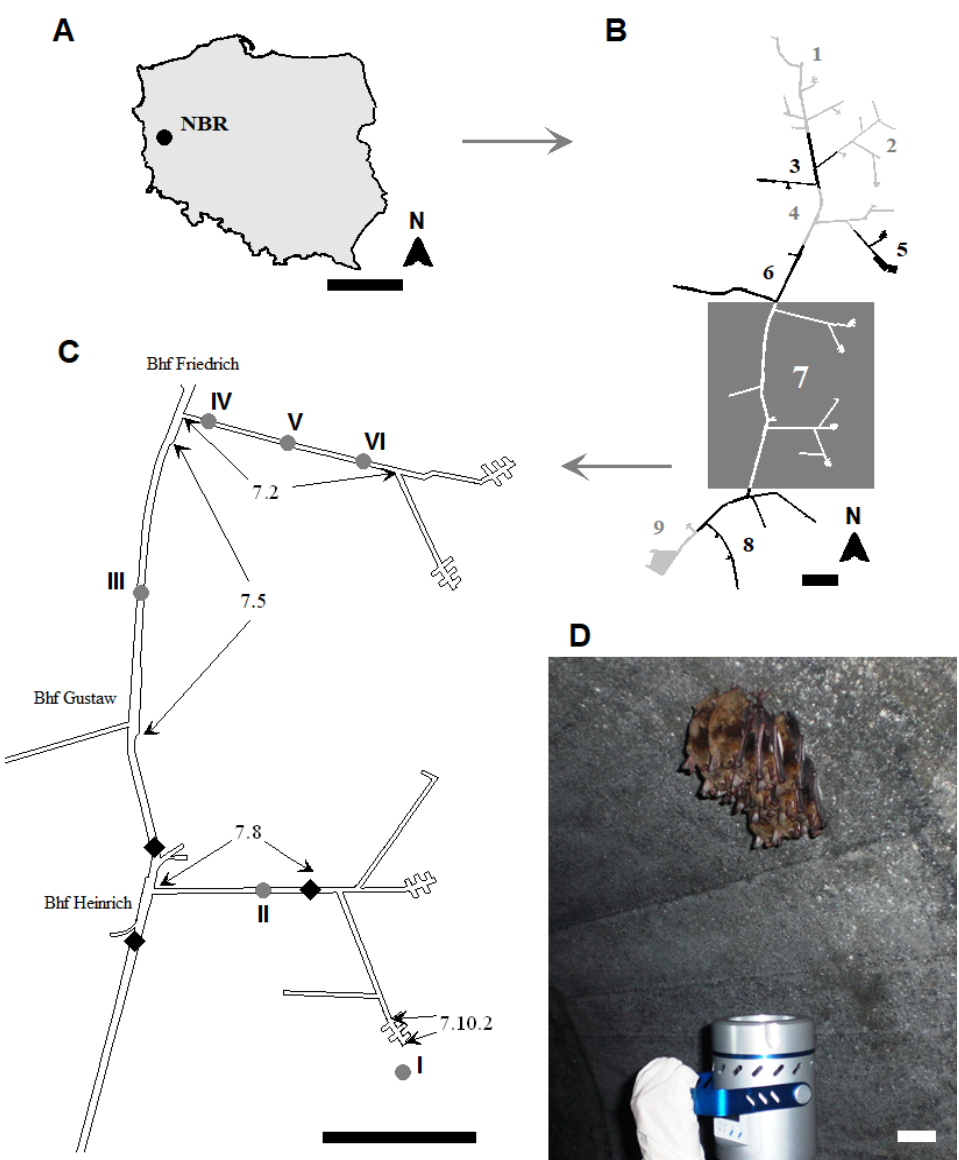
Figure 1. ( A ) Geographic location of Nietoperek bat reserve (NBR) in Western Poland. Scale bar = 250 km. ( B ) The outline of the underground fortification system divided into 9 sections for bat monitoring purposes. Scale bar = 500 m. ( C ) Area highlighted in (B) shows sampling sites I-VI in section 7 and one site outside the underground fortification system (location I—near section No. 7.10.2) and inside the underground fortification system in sector No. 7: locations II (section No. 7.8), III (section No. 7.5), IV, V, and VI (respectively, beginning of section No. 7.2, center, and end of it). Scale bar = 500 m. ( D ) Air sampling (locations from IV–VI) under hibernating M. myotis for the mycological analysis. Black diamonds mark security gates. Scale bar = 5 cm.